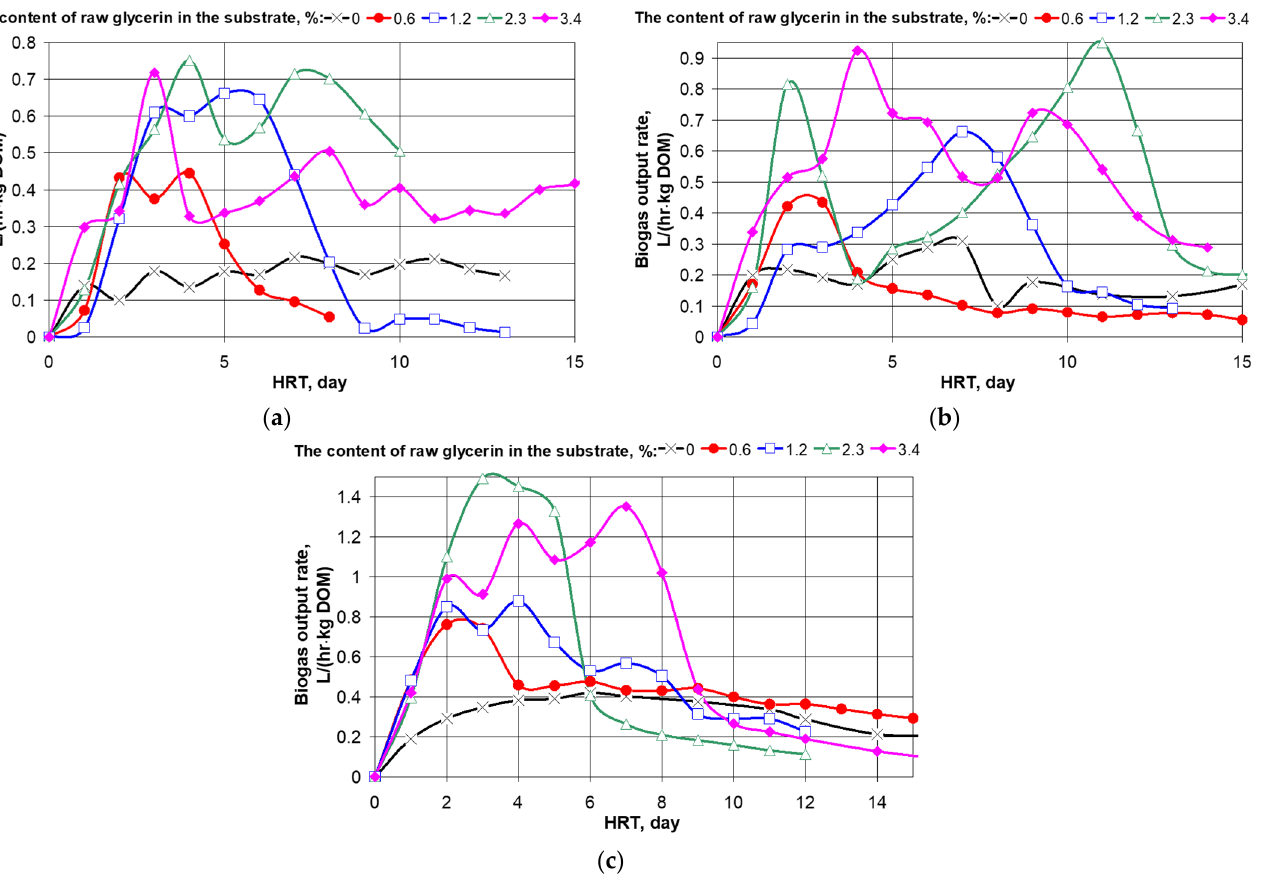
Figure 2. The rate of biogas yield during fermentation of cattle manure with the addition of crude glycerine at the fermentation temperature: ( a ) 30 ° С , ( b ) 35 ° С , and ( c ) 40 ° С . glycerine at the fermentation temperature: ( a ) 30 ◦ C, ( b ) 35 ◦ C, and ( c ) 40 ◦